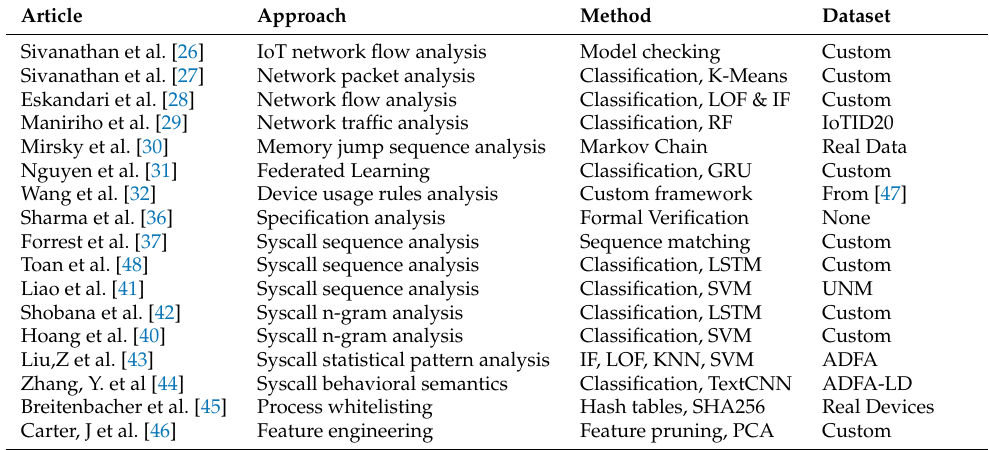
Table 1. Summary of the related work that highlights the used approaches, methods, and